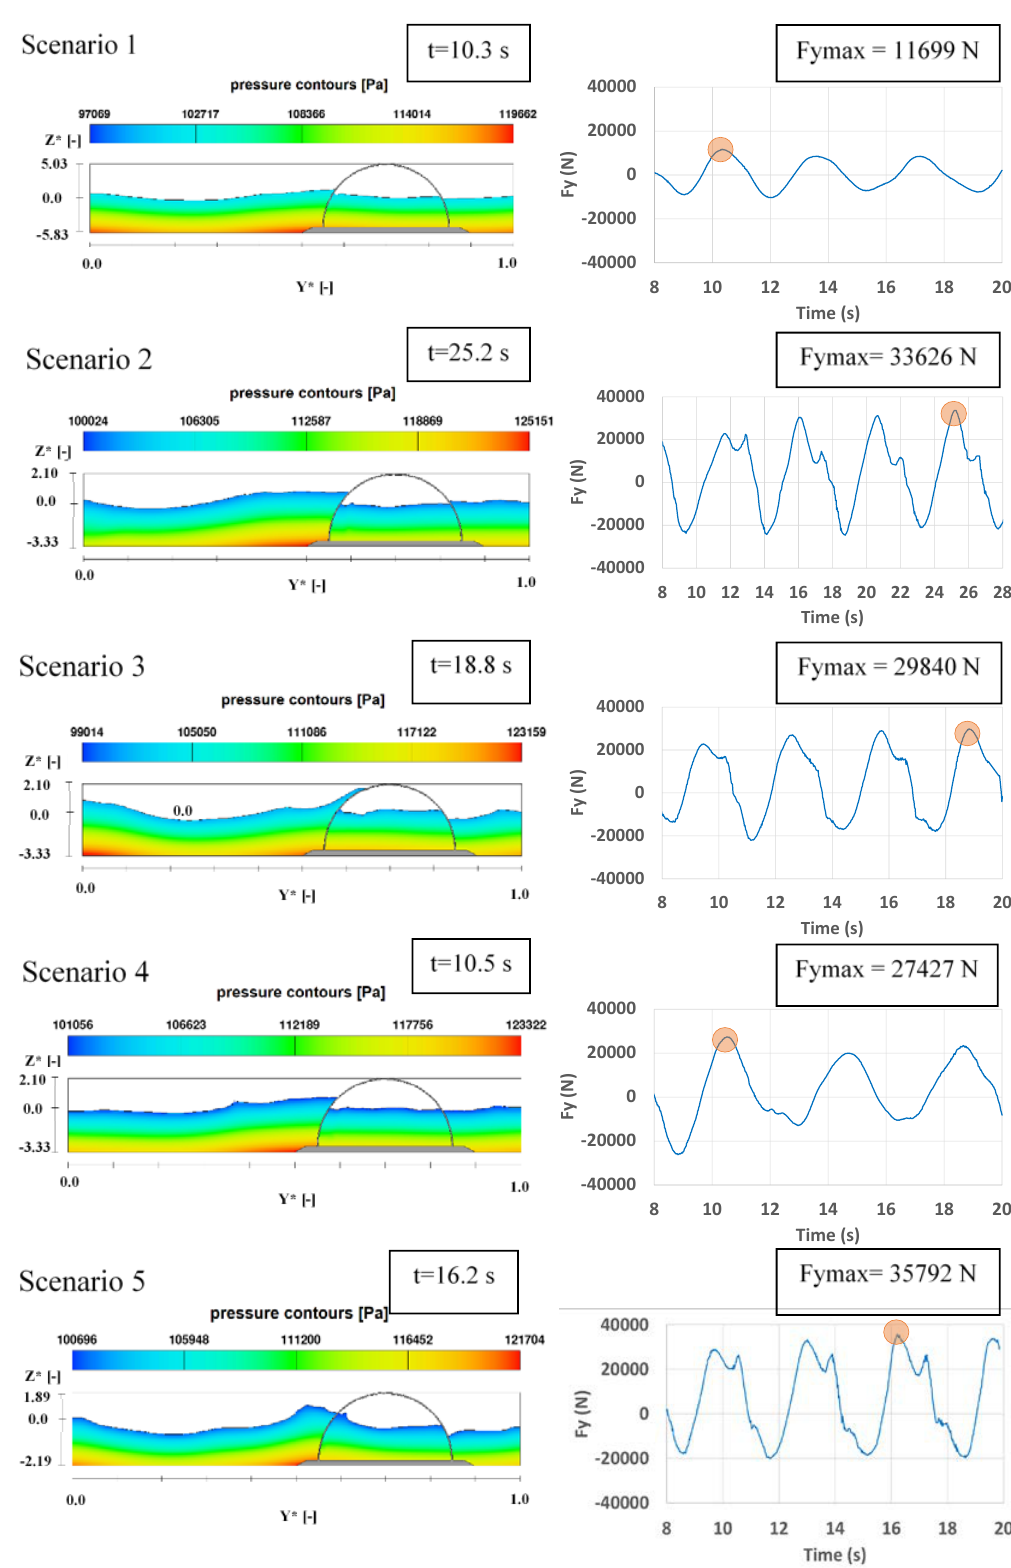
Figure 4. Results of pressure and dimensionless free surface elevation (Z*) along the dimensionless channel length (Y*) at the instant when the horizontal component of the pressure force is maximum (left) and variation of the horizontal pressure force over the simulation time (right).